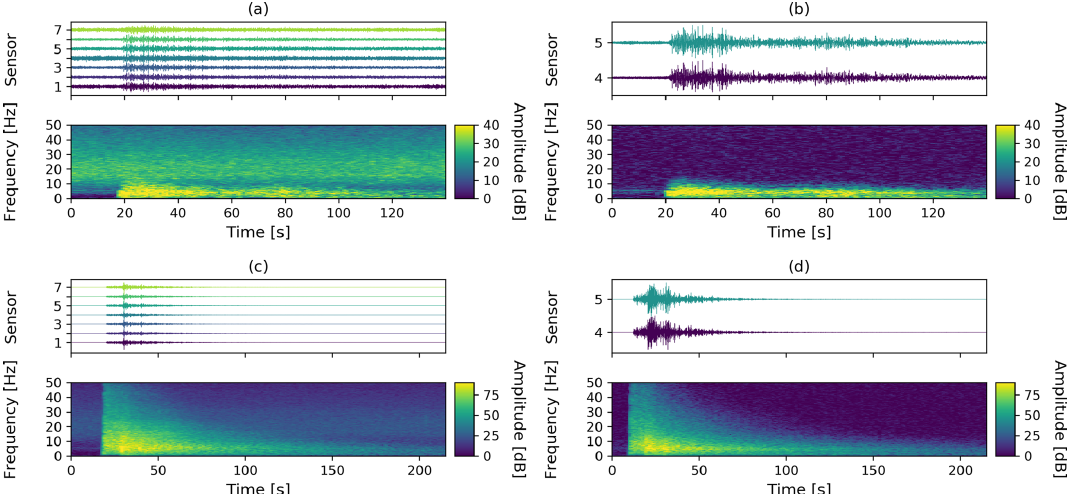
Figure 9. Time series and corresponding spectrograms for two false classifications: an airplane detected at (a) Dischma and (b) at Wannen- grat, and an earthquake detected at (c) Dischma and (d) Wannengrat.